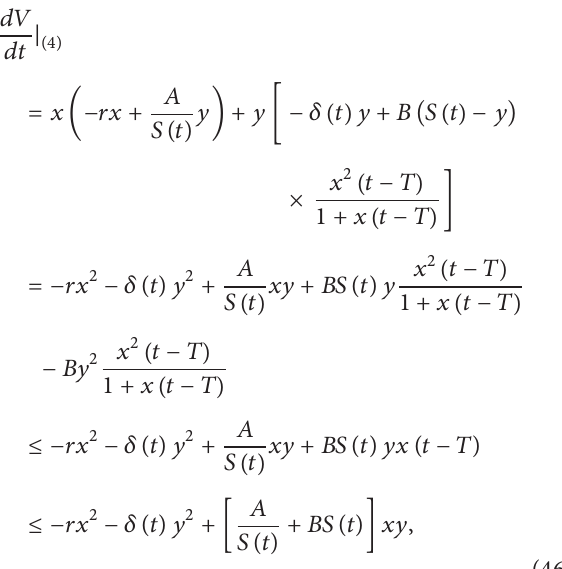
Figure 2: Coexistence of a stable zero solution (solid squares and circles, 𝑦 0 = 0.2 , 𝑥 0 (𝜃) = 0.2 ) and a periodic solutions (dots and hollow squares, 𝑦 0 = 2,𝑥 0 (𝜃) = 2 ) where 𝐴 = 0.6 , 𝐵 = 0.4 , and 𝑟 = 0.8